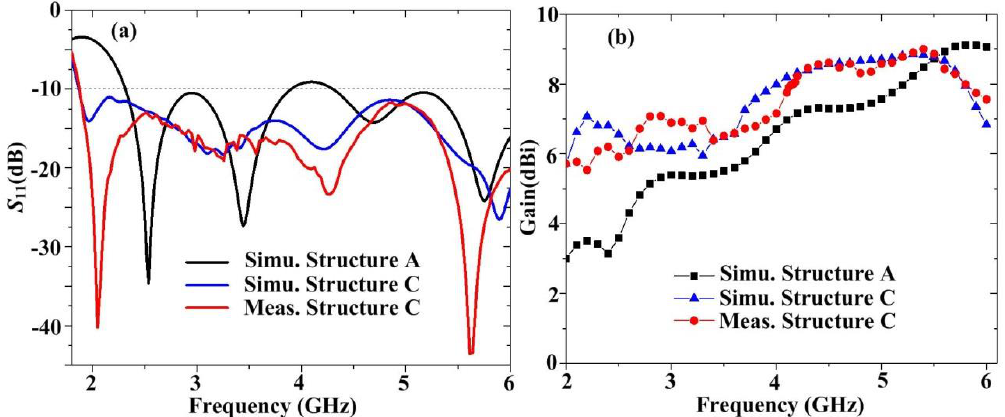
Figure 7. ( a ) The simulated and measured reflection coefficients of structures A and C (the typical AVA and the plasmonic AVA); ( b ) the simulated and measured gains of structures A and C.